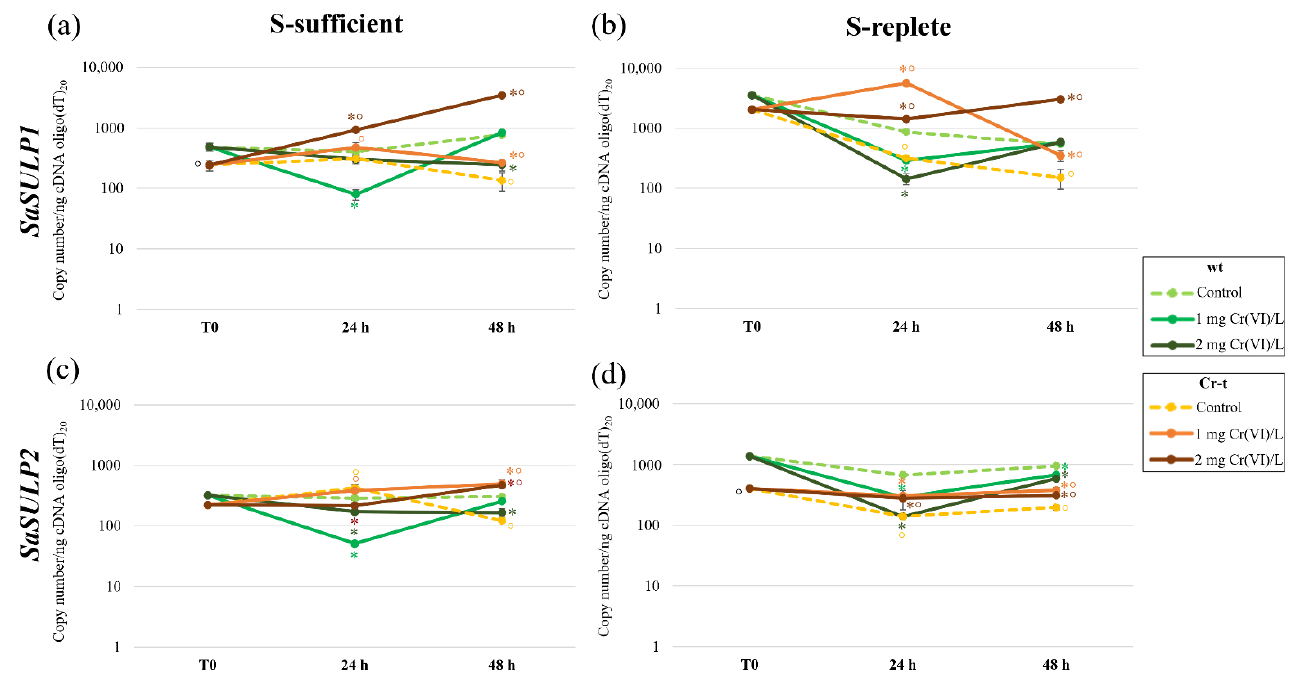
Figure 11. aqPCR of SaSULP1 ( a , b ) and SaSULP2 ( c , d ) in both S-sufficient and S-replete conditions. Statistical analysis was performed by using one-way ANOVA with the Tukey post hoc test ( p < 0.05) after the Shapiro-Wilk normality test. *: significant difference between Cr-treated (with 1 or 2 mg Cr(VI)/L) and untreated cells within strain. ◦ : significant difference between the two strains in similar